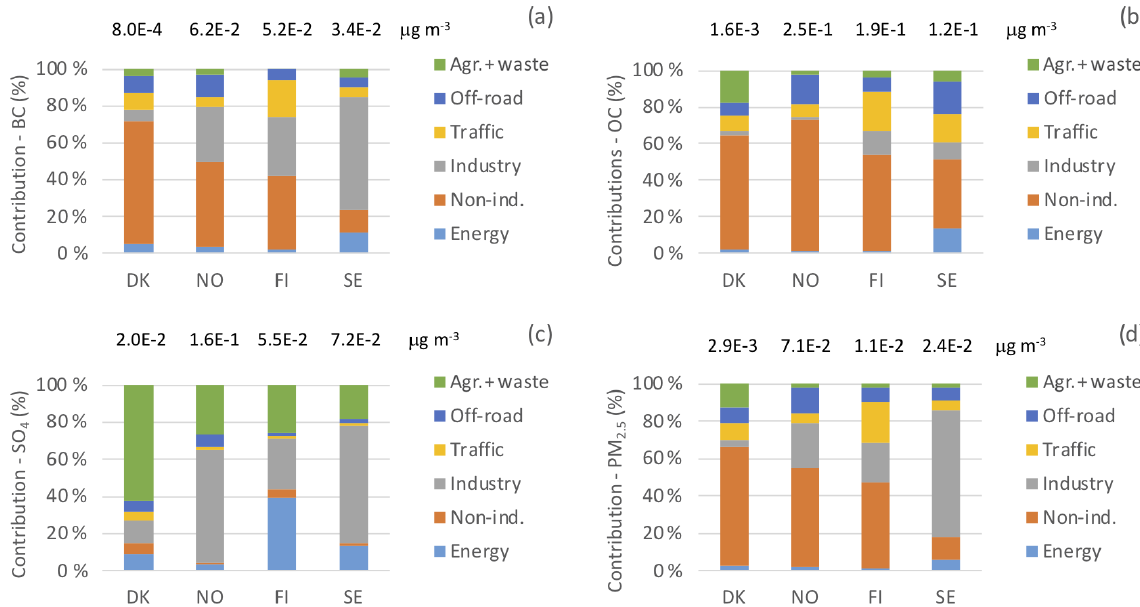
Figure 10. Population-weighted sectoral contributions from (a) Denmark, (b) Norway, (c) Finland and (d) Sweden to the surface aerosol levels over the Arctic (north of 67 ◦ N). The labels above the bars show the absolute total contribution in µgm − 3 from all the sectors in each source country.